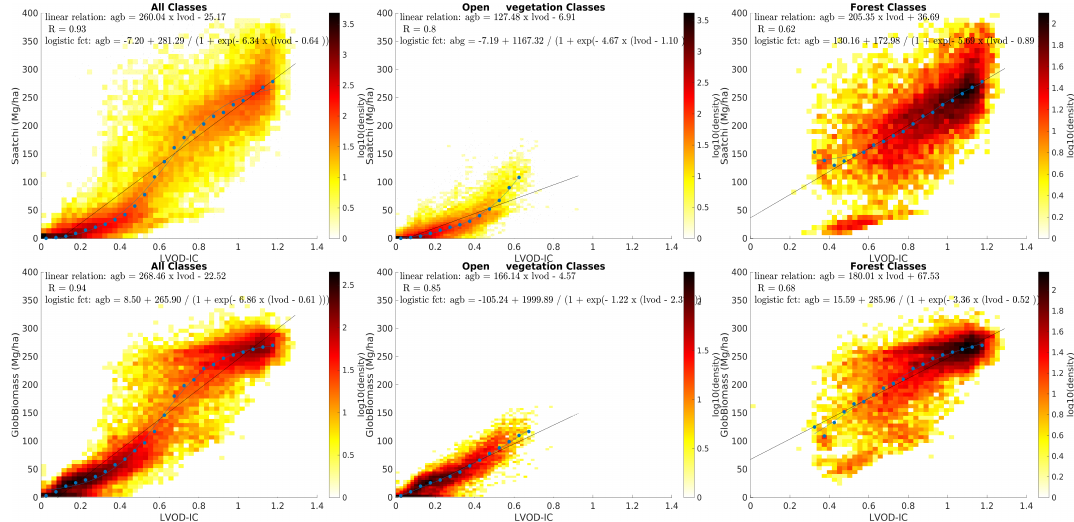
Figure 4. AGB Saatchi ( top row ) and GlobBiomass ( bottom row ) as a function of L-VOD over the tropical region. left column Figures are for all IGBP classes, middle column for low vegetation classes, and right column are for forest